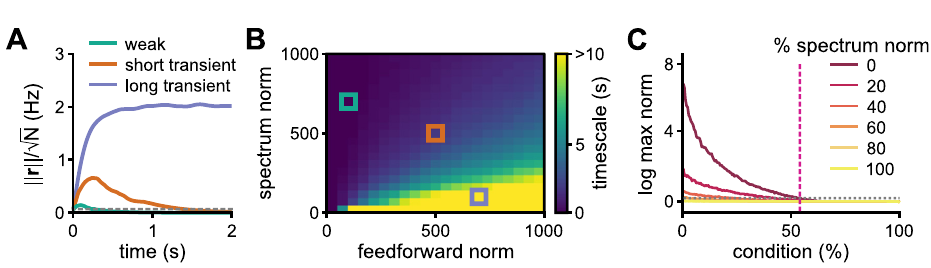
Fig 5. Amplification regimes. A , Representative examples of non-normal amplification defined by the timescale of the transient response of the nonlinear network—period, Δ t , for which k r ( t ) k � 1: “weak” ( Δ t � 500 ms); “short transient” (500 < Δ t < 2000 ms); and “long transient” ( Δ t � 2000 ms). Grey dotted line indicates k r k = 1. B , Timescale of the response in the nonlinear network (as in panel A), parametrised by the norms of the spectrum and feedforward structure. Yellow indicates timescale longer than 10 seconds. Boxes correspond to the values used for the plots in panel A (colour coded): (feedforward norm, spectrum norm) = (100, 700), (500, 500), and (700, 100) for weak, short transient, and long transient, respectively. C , Maximum norm of the dynamical response per initial condition for different percentages of the norm assigned to the spectrum, ranging from a matrix whose entire norm is assigned to the spectrum (yellow; 100% case, normal matrix) to a matrix whose entire norm is assigned to the feedforward part (dark red; 0% case, nilpotent matrix). The network size is N = 200 in all panels. Both eigenspectrum and feedforward structures are random